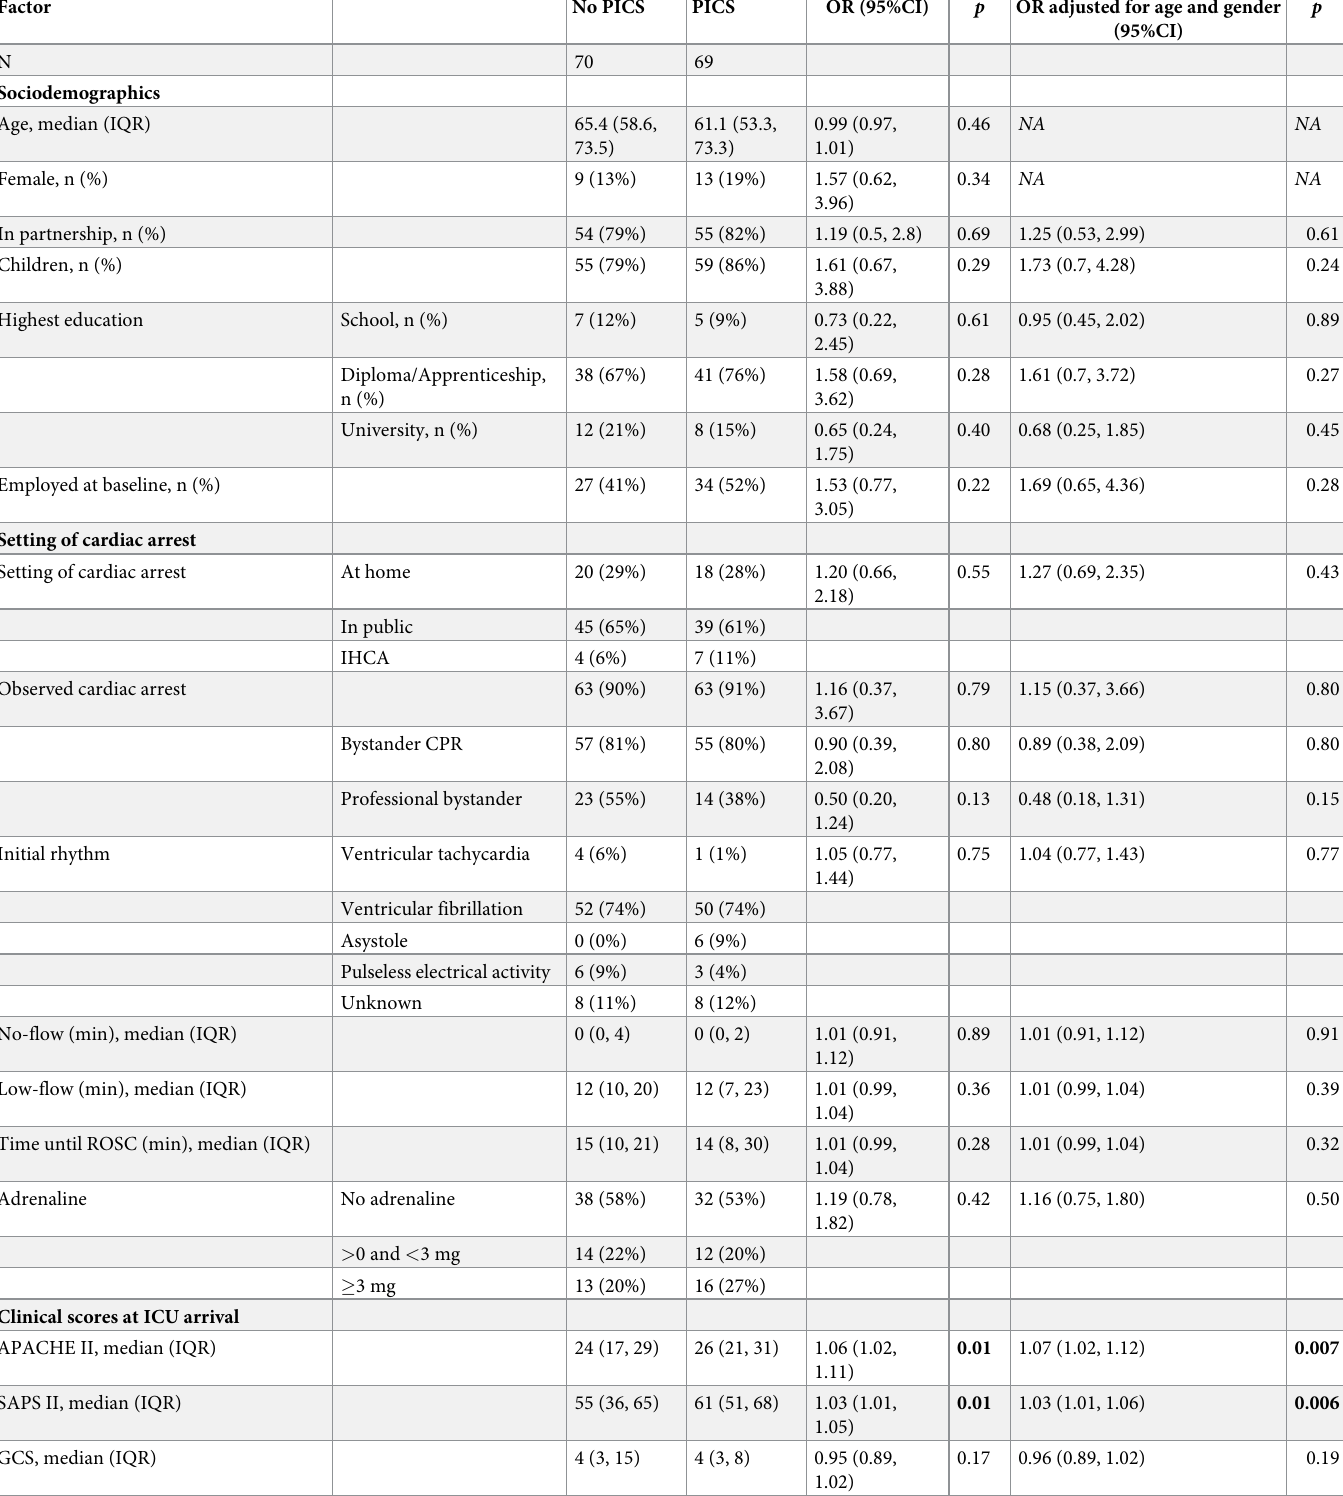
Table 2. Associations of predictor variables and post-intensive care syndrome at 3